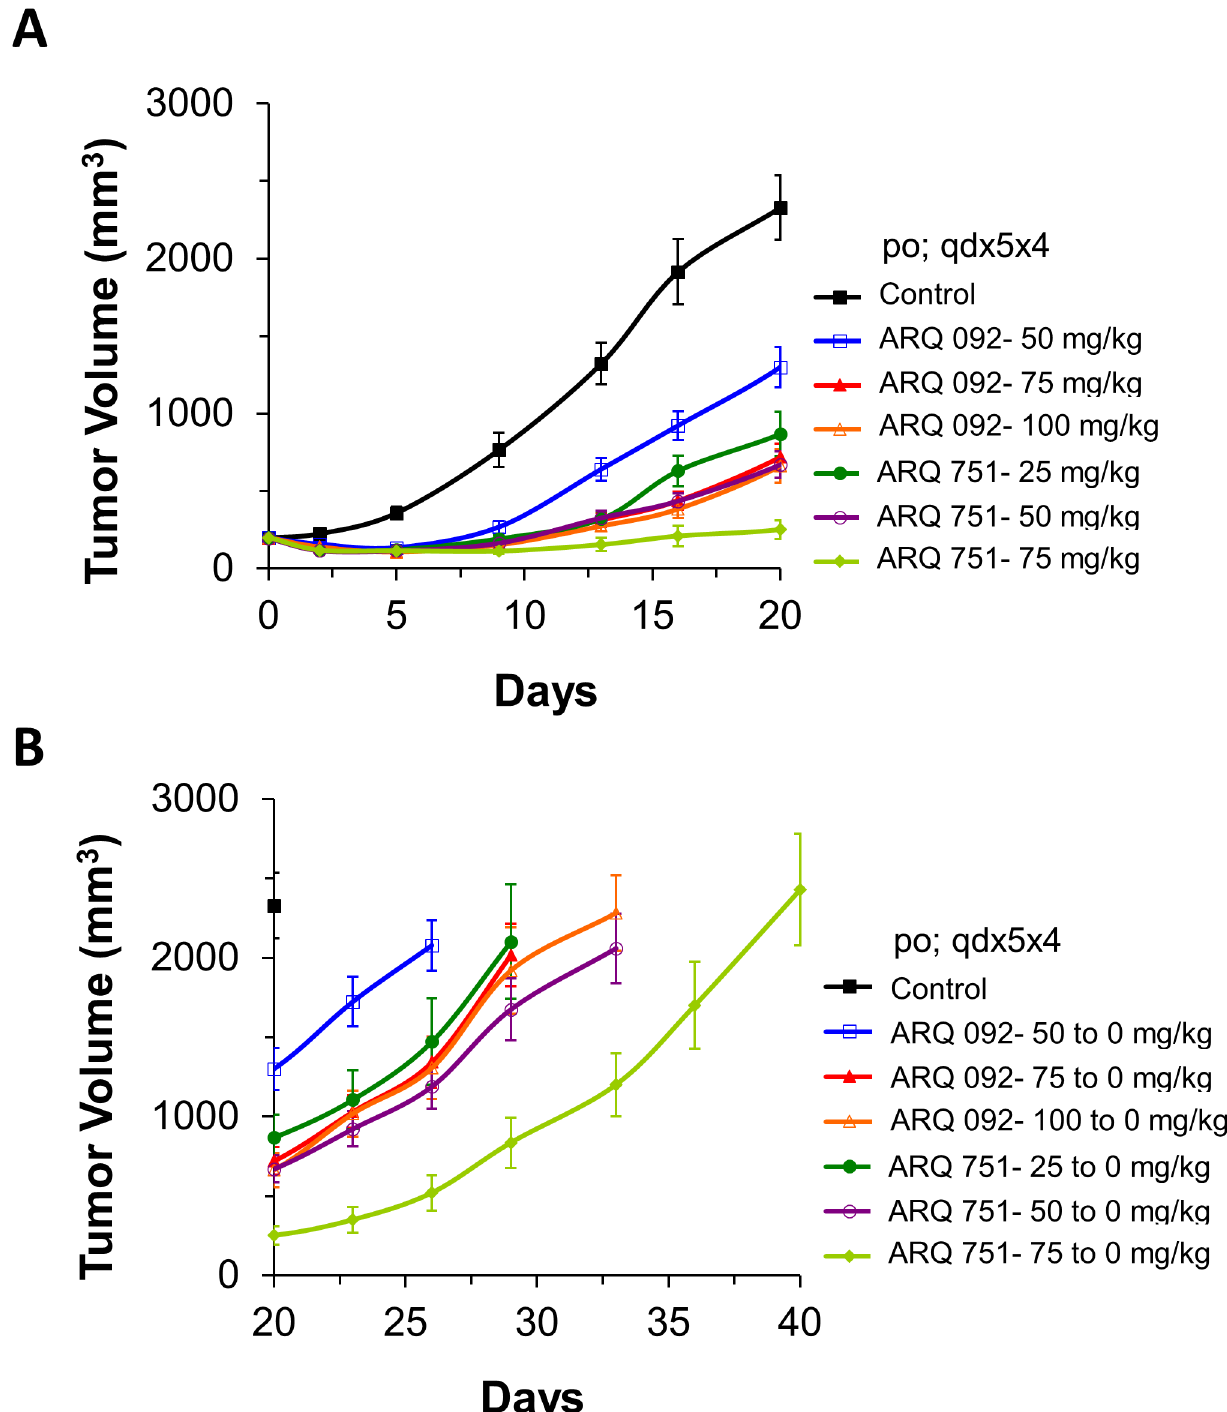
Fig 7. Antitumor activity in endometrial PDX mouse xenograft models after treatment with ARQ 092 or ARQ 751. An endometrial PDX mouse xenograft model, ARQ 092 dosed at 50, 75 or 100 mg/kg or ARQ 751 dosed at 25, 50, 75 mg/kg in a schedule of 5 days on and 2 days off for 20 days. (A) Plot of tumor growth inhibition. (B) Plot of tumor regrowth after removal of drug. (Day 20 to Day 40).